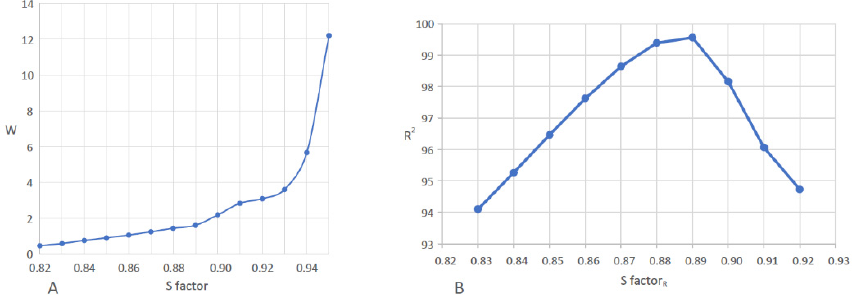
Figure 3. Study of the first case corresponding to Figure 1. ( A ) Representation of W as a function of S factor values. ( B ) Evolution of the model fit as a function of S factorR .